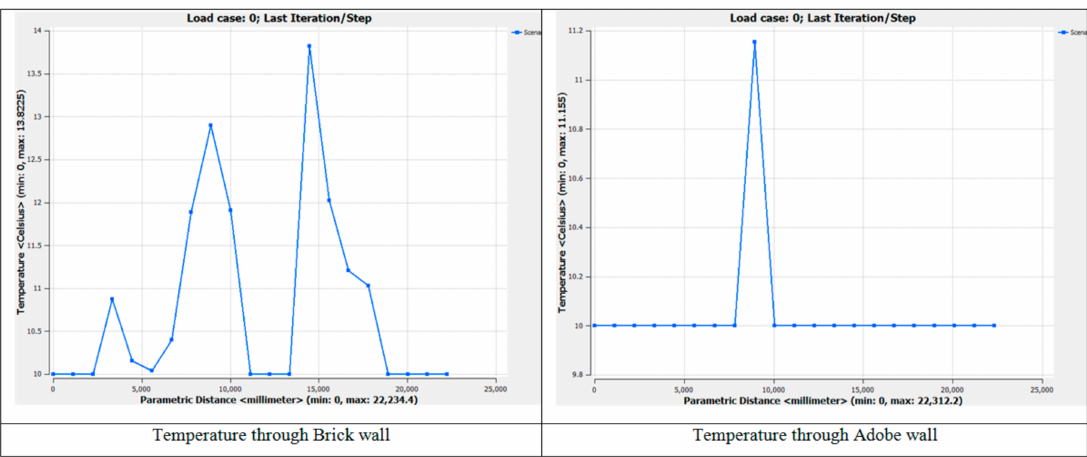
Figure 12. Calculated Temperatures through the Apartments. CFD Autodesk 2016, 21 April